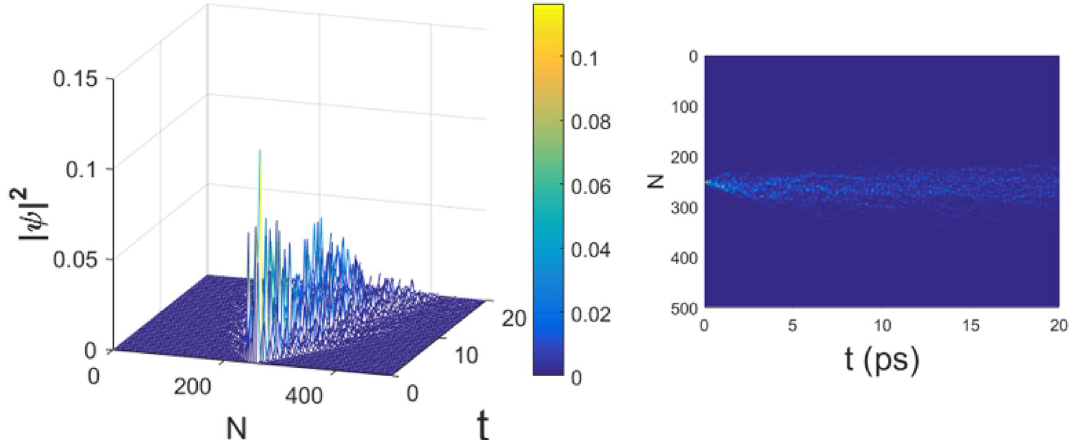
2 500 and χ 3 ( χ 366 pN); ψ( t ) with N ′ = = = | | 13 s.